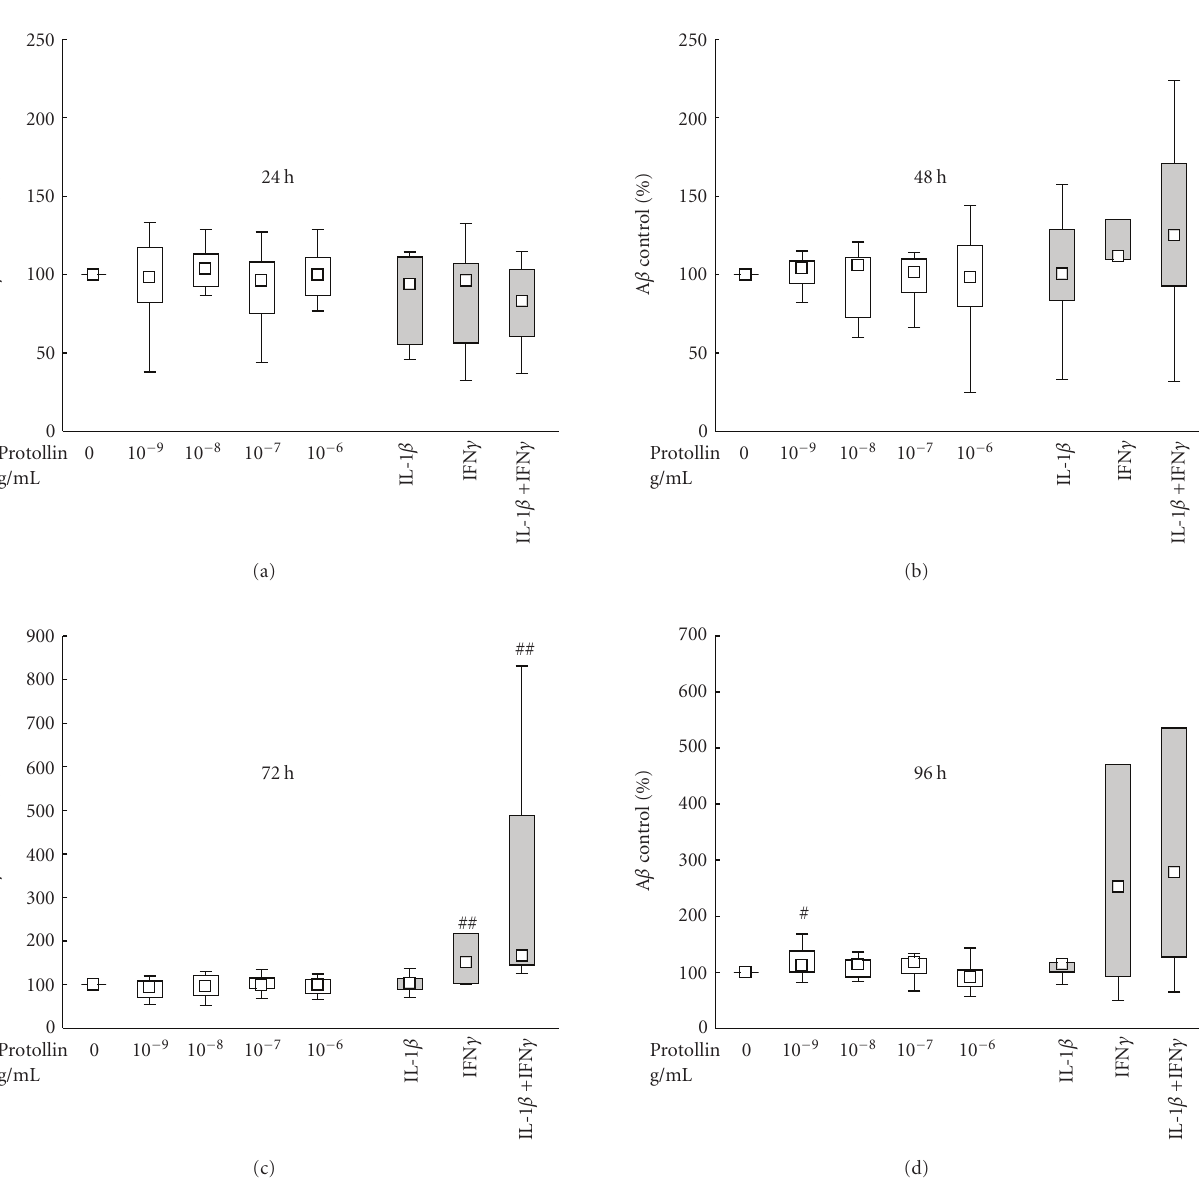
Figure 4: E ff ects of Protollin (white boxes) and interleukin-1 β (IL-1 β ) and interferon- γ (IFN γ ) (grey boxes) on the uptake of A β 1 – 42 in human CHME3 microglial cells. The cells were incubated with 1 μ g/mL A β 1 – 42 following prestimulation for 24 hours with Protollin at 0.001–1 μ g/mL, or 50ng/mL IL-1 β and 50ng/mL IFN γ . The cells were harvested at 24, 48, 72, and 96 hours after addition of A β 1 – 42 . The data are expressed as % uptake of control A β 1 – 42 set at 100%, and shown as median ± percentiles (25%–75% and 10%–90%), n = 19 (Protollin) or n = 4 (cytokines) for 24 and 48 hours, and n = 17 (Protollin) of n = 6 (cytokines) for 72 and 96 hours. A statistically significant e ff ect of treatment was found by Kruskal-Wallis ANOVA at 96 hours when incubating microglia with Protollin ( P = . 0157) and at 72 hours when incubating with IL-1 β and/or IFN γ ( P = . 0022). Statistical di ff erence from control is indicated by # ( P < . 05), ## ( P < . 01), and ### ( P < . 005) indicates statistical di ff erence ( P < . 01) between IL-1 β and IL-1 β +IFN γ